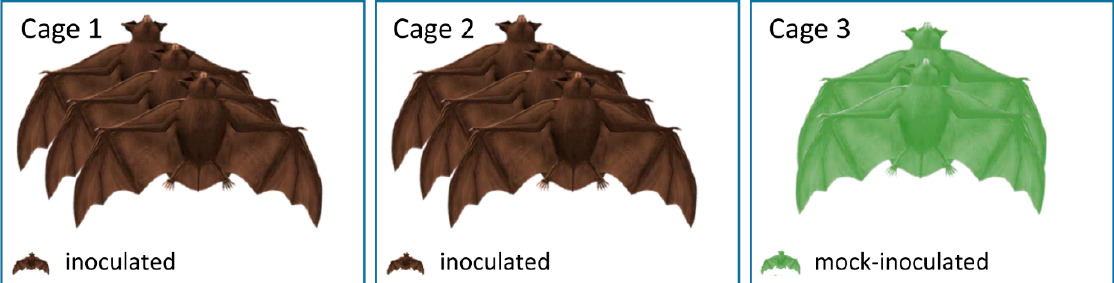
Figure 1. Experimental design of the experiment with “A/layer chicken/Bangladesh/VP02-plaque/2016 (H9N2)”. Three inoculated bats each were housed in two separate cages. The two mock-inoculated individuals were housed separately in cage 3.